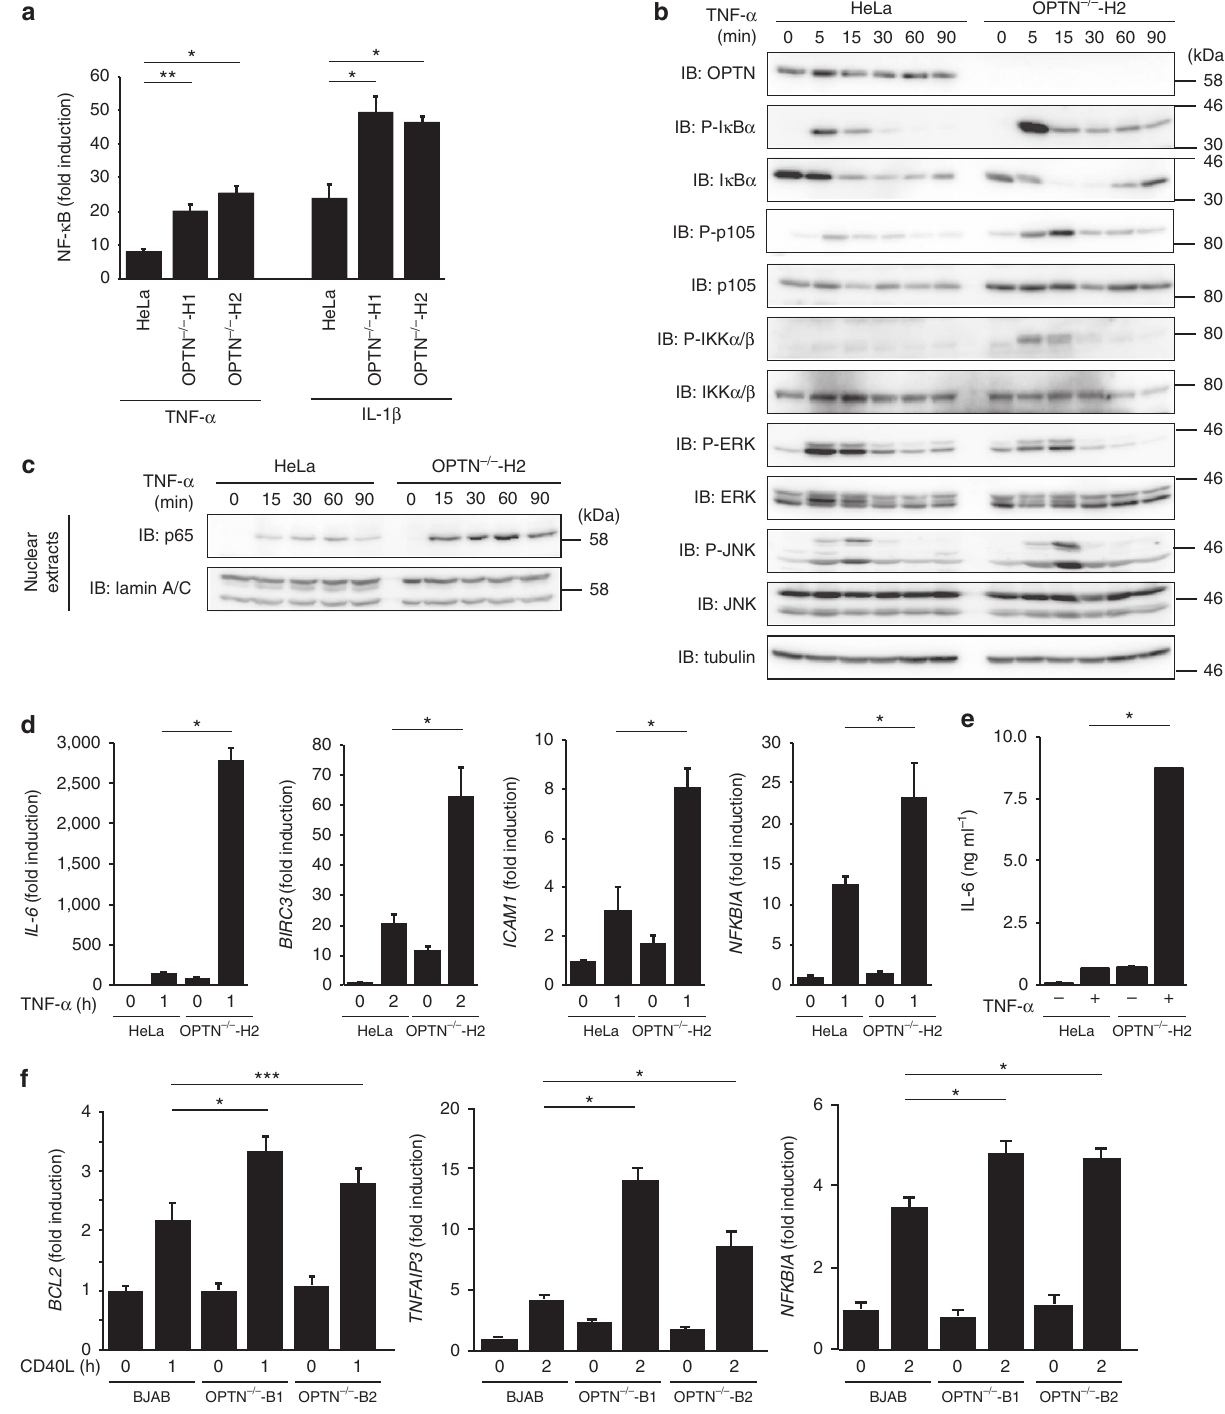
Figure 3 | Enhanced NF- j B activation in OPTN -KO cells. ( a ) TNF- a - and IL-1 b -induced NF- k B luciferase activities in OPTN -KO HeLa cells and their parental cells. ( b ) Enhanced NF- k B activation in TNF- a -treated OPTN -KO HeLa cells. Cells were treated with TNF- a for the indicated times and immunoblotting was performed using the indicated antibodies. ( c ) Accelerated TNF- a -induced nuclear translocation of p65 in OPTN -KO HeLa cells. ( d ) Quantitative PCR (qPCR) analyses of NF- k B targets in TNF- a -treated parental and OPTN -KO HeLa cells. Relative expression of target mRNAs was analysed using GAPDH as an internal standard. ( e ) Quantification of secreted IL-6 from TNF- a -treated parental and OPTN -KO HeLa cells. ( f ) qPCR analyses of NF- k B targets in CD40L-treated parental and OPTN -KO BJAB cells. ( a , d , e , f ) Mean ± s.e.m. ( n ¼ 3). Statistical significance was assessed using one-way analysis of variance. * P o 0.001, ** P o 0.01 and *** P o